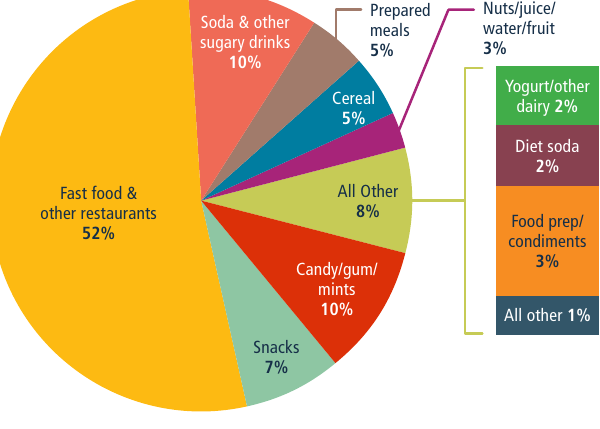
Advertising spending on Black-targeted TV: $195